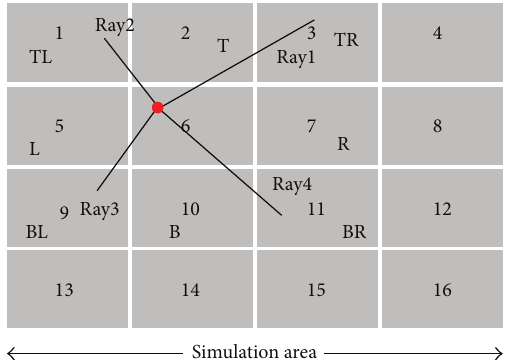
Figure 5: Illustration of neighbor cell selection technique based on the quadrant of the travelling ray.